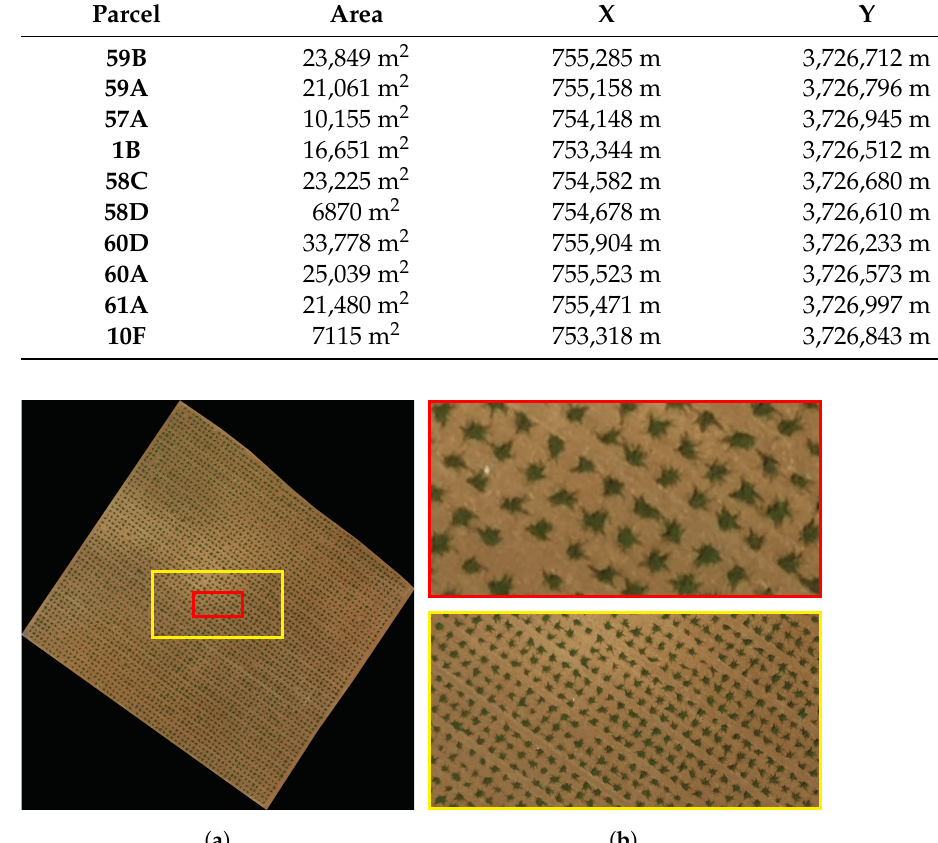
Figure 1. Goblet trained parcel. ( a ): whole image, ( b ): magnified